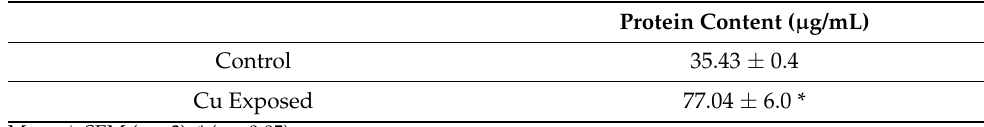
Table 2. Change in total protein content in control and copper-treated P. multimicronucleatum culture after 24